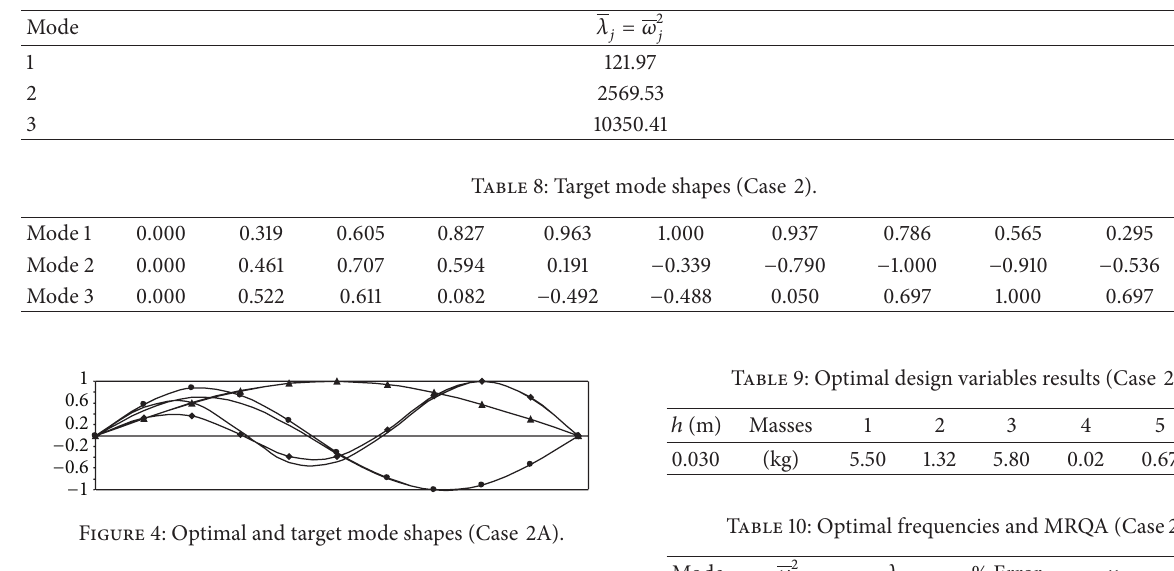
Table 7: Target frequencies (Case 2).